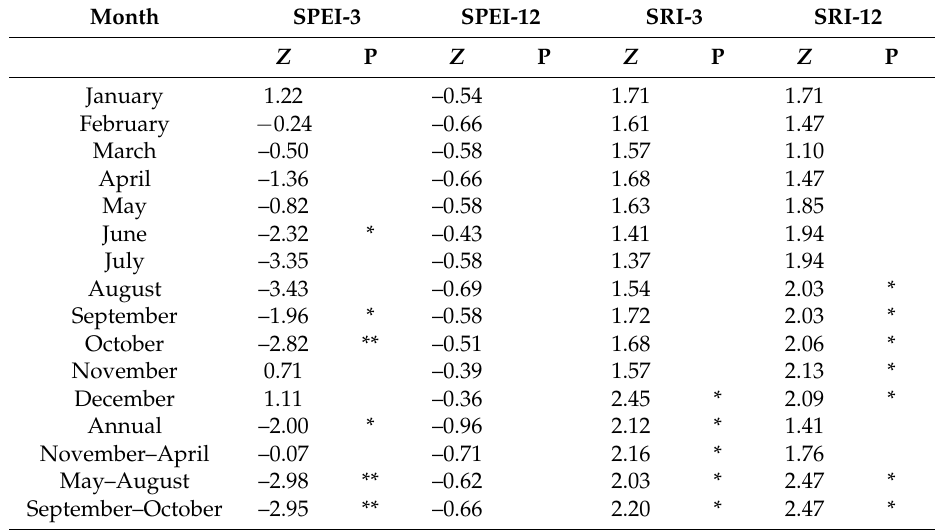
Table 6. Mann–Kendall (MK) test trend analysis calculated from SPEI/SRI at 3- and 12-month time scale.